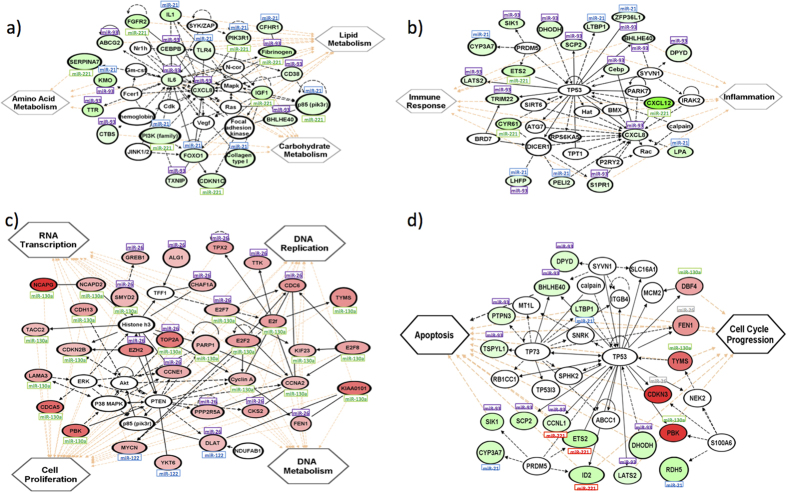
Gene networks inferred from differentially expressed miRNA targets with similar functional annotation based on KEGG gene ontology: (a) Targets of up-regulated miRNAs involved in metabolism; (b) Targets of up-regulated miRNAs involved in immune system processes; (c) Targets of down-regulated miRNAs associated with DNA replication; and d) Targets of up- and down-regulated miRNAs involved in cell growth and death.